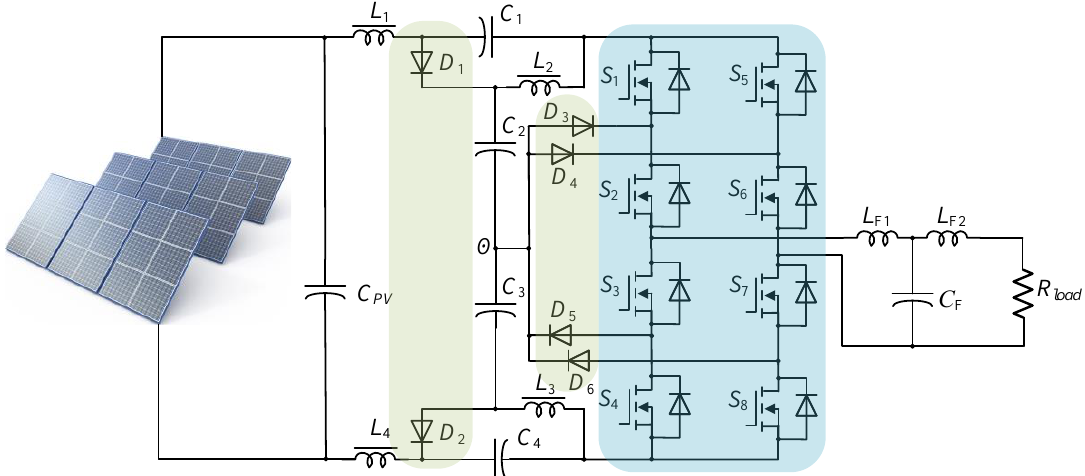
Figure 3. The 3l NPC QZS inverter.